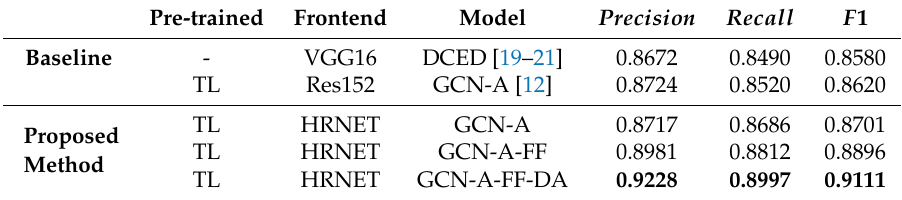
Table 7. Effects on the testing set of ISPRS Vaihingen (Stuttgart) challenge data set.